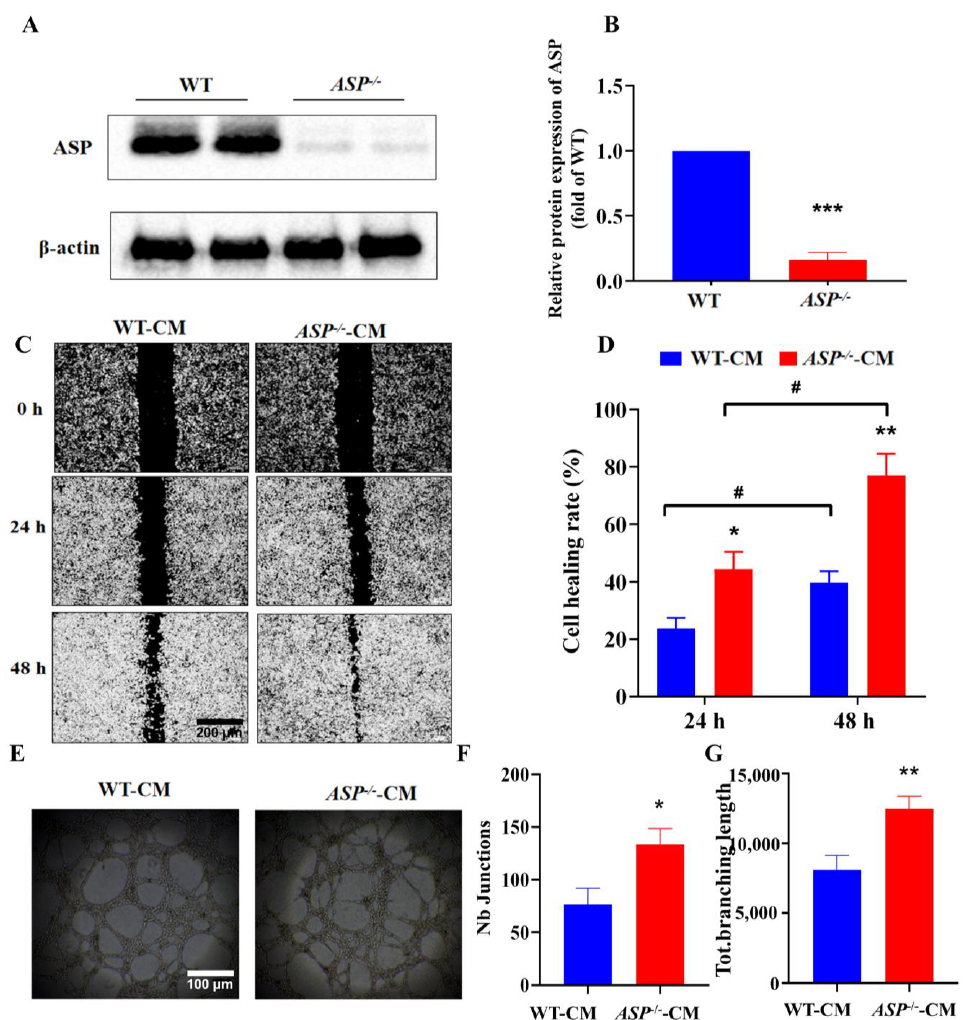
Figure 3. ASP -knockout promotes the migration and angiogenesis of vascular endothelial cells in vitro. Identification of ASP- knockout in 3T3-L1 adipocytes by Western blot ( A , B ). Wound-healing assay in exposure of HUVECs to ASP -/- -CM or WT-CM for 24 h or 48 h ( C , D ). Angiogenesis assay of HUVECs in vitro by a Matrigel system ( E – G ). Data are presented as mean ± SEM from three inde- pendent experiments ( n = 3). Two-way ANOVA was performed, followed by an unpaired two-tailed Student’s t -test for Figure C and D; an unpaired two- tailed Student’s t -test was used in other figures. * p < 0.05, ** p < 0.01, *** p < 0.001, vs. the WT group or the WT-CM group; # p < 0.05, vs. 24 h. WT: wild type 3T3-L1 preadipocytes; ASP -/- : ASP -knockout of 3T3-L1 preadipocytes; WT-CM: conditional me- dium from WT-3T3-L1 adipocytes; ASP -/- -CM: conditional medium from ASP -/- - 3T3-L1 adipocytes; Nb: numbers, Tot: total. Scale bars: 200 μm ( C ) and 100 μm ( E ). ASP : asprosin.